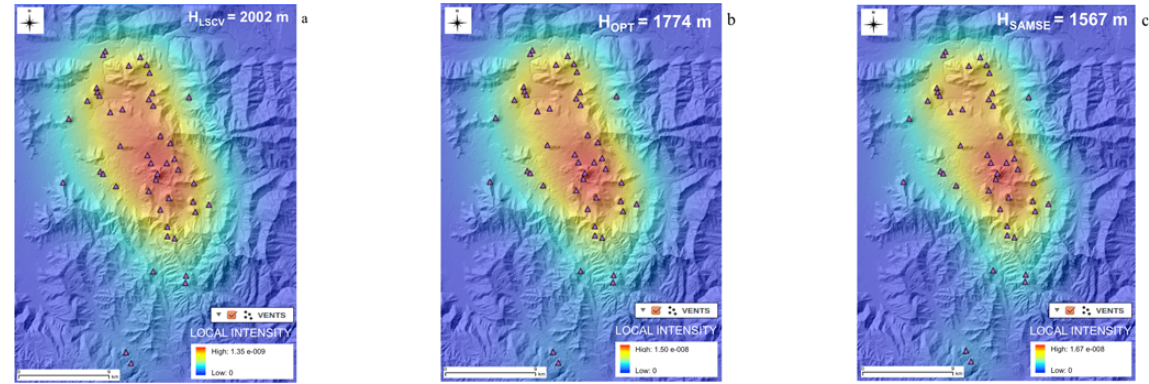
Fig. 11. PDFs of La Garrotxa emission centers calculated with the Gaussian kernel using different bandwidths: 2002m as computed by the LSCV method (a) , 1774m as by the h opt score (b) , and 1567m as by the SAMSE selector (c) .